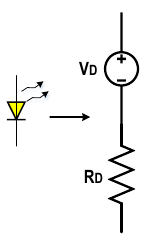
Figure 3. LED model.